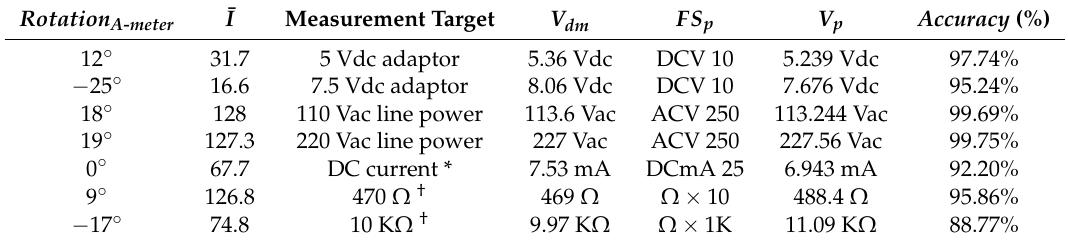
Table 10. Results of comparing the measurements ( V dm ) with a digital multimeter (model DMM-85) to those ( V p ) with the A-meter YF-370A read by the proposed method. The mean accuracy was 95.61%. Rotation A-meter ¯ I Measurement